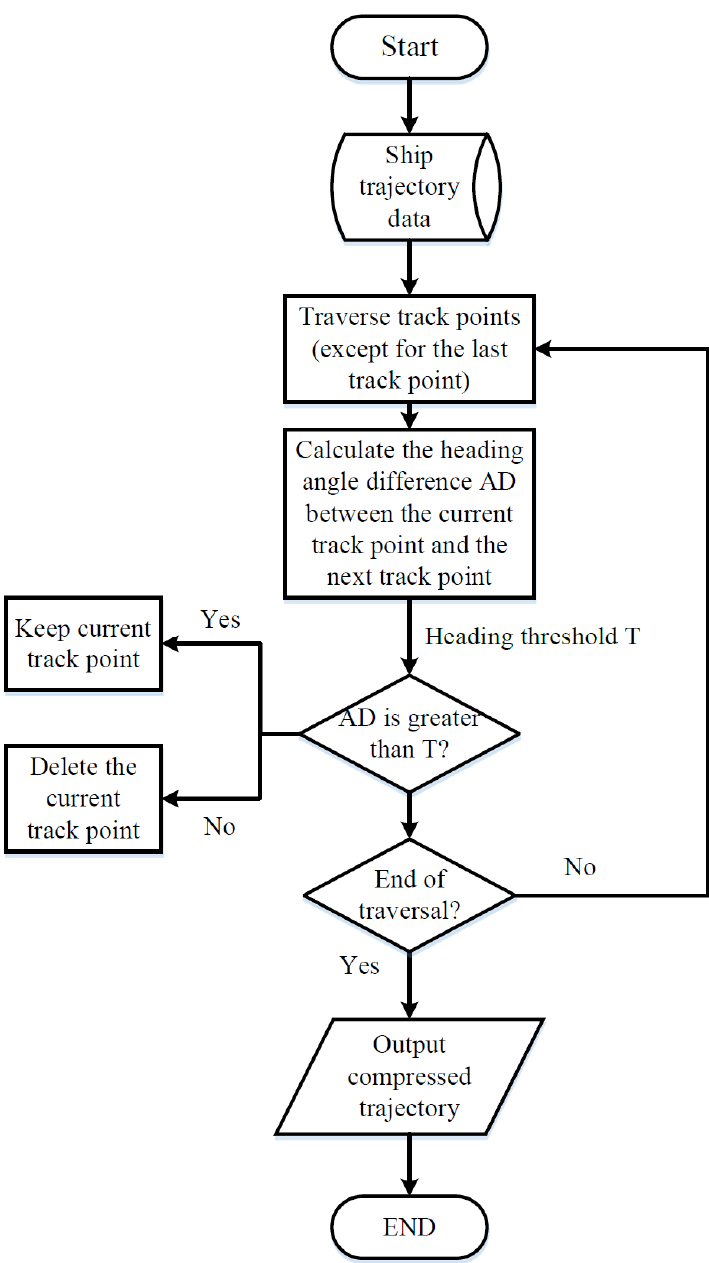
Figure 3. Heading angle difference.